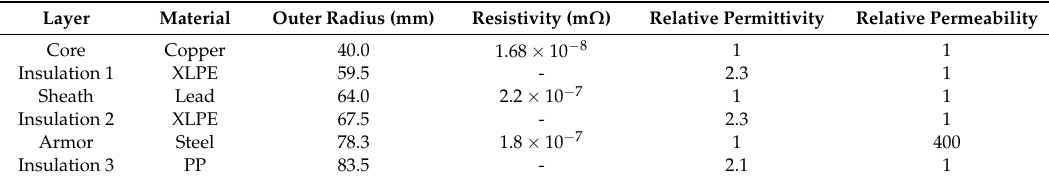
Table 1. Transmission cable properties (300 kV XLPE).